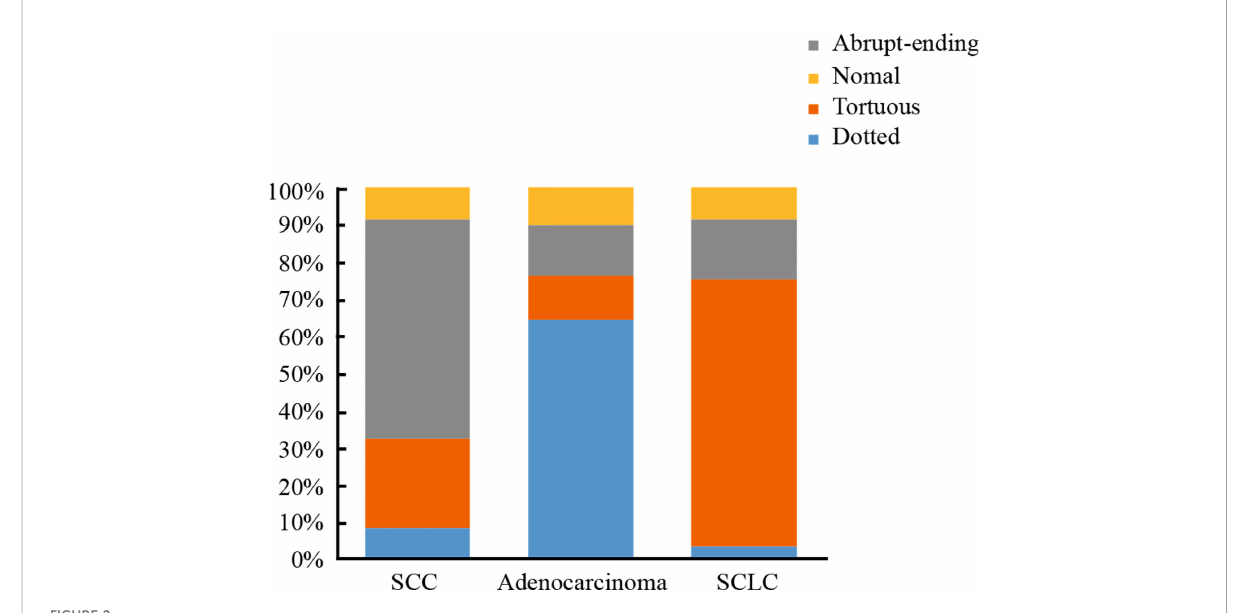
FIGURE 2 The proportion of vascular patterns in different histological types of lung